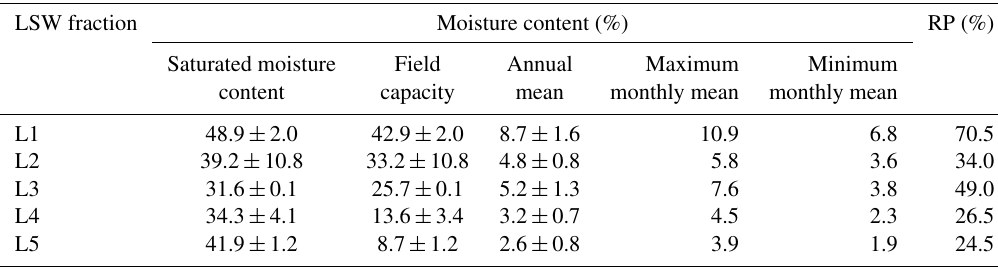
Table 2. Hydro-physical properties of LGM. LSW fraction Moisture content (%) RP (%) Saturated moisture Field Annual Maximum Minimum content capacity mean monthly mean monthly mean L1 48.9 ± 2.0